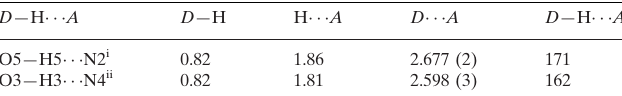
Hydrogen-bond geometry (A˚ , (cid:3)